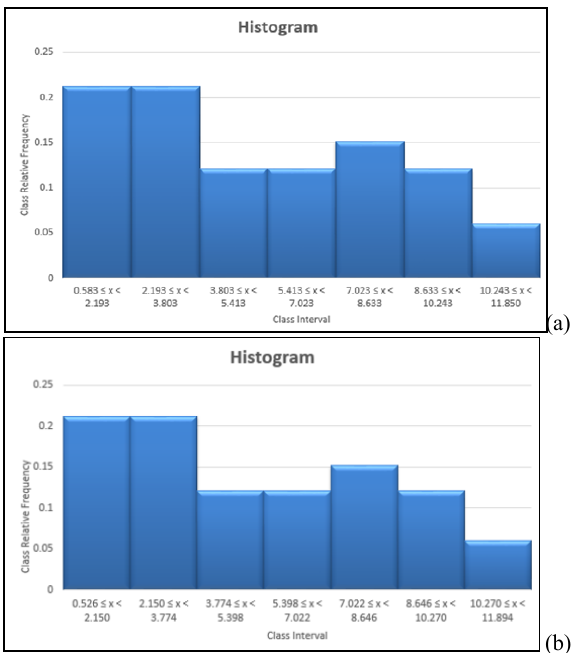
Figure 11. Class Frequency Table; (a) POI, (b) Waypoints